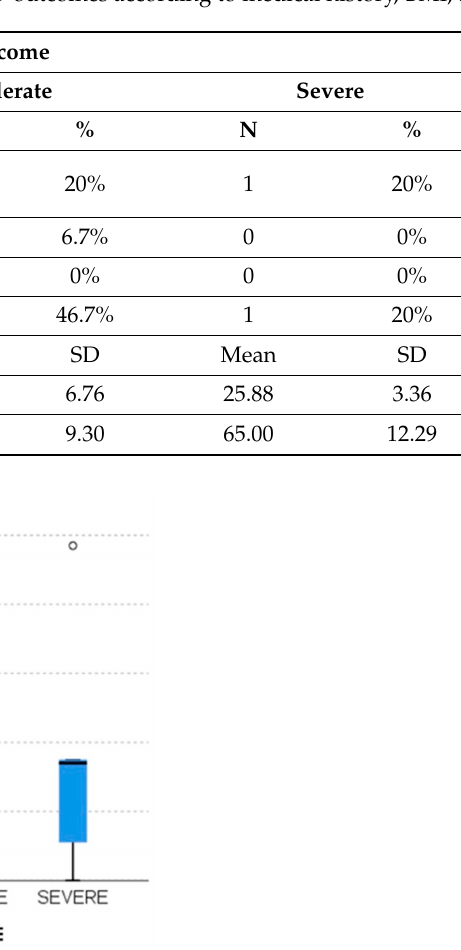
Table 6. Differences in COVID-19 outcomes according to medical history, BMI, and age.